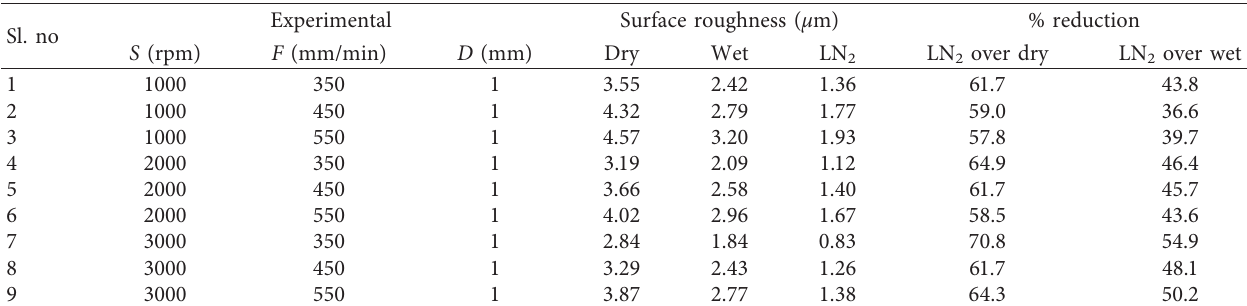
Figure 3: SEM image of the EDS spectra of SS316. (a) SEM image of workpiece SS316. (b) Element composition weight (%) of workpiece SS316 using EDS. (c) SEM image of the EDS spectra of SS316 in color scale. (d) SEM image of the EDS spectra of SS316 in black and white scale. Table 3: Experimental dataset: one-factor